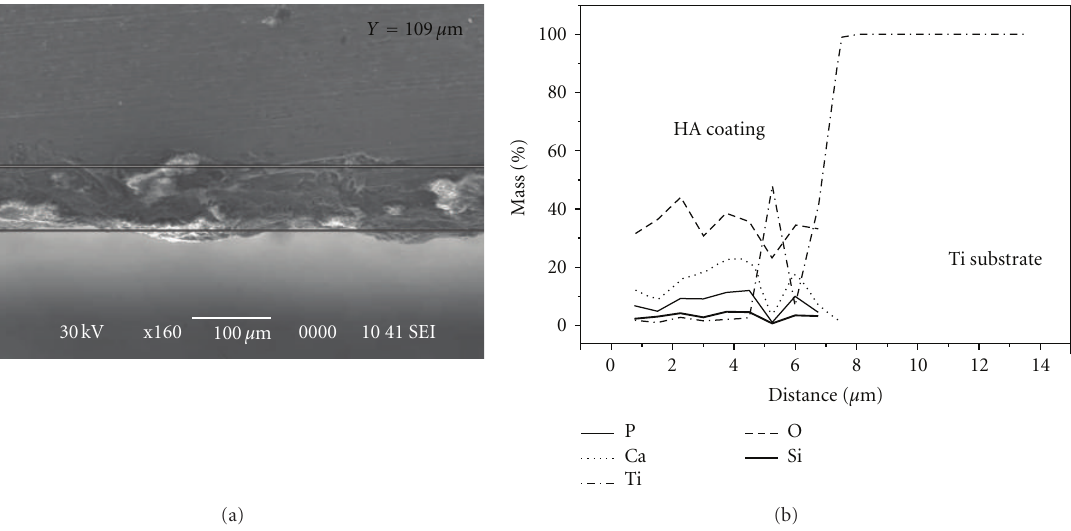
Figure 17: Structure of as-synthesized SiHA coating produced by MA method: (a) cross-section microstructure, (b) concentration